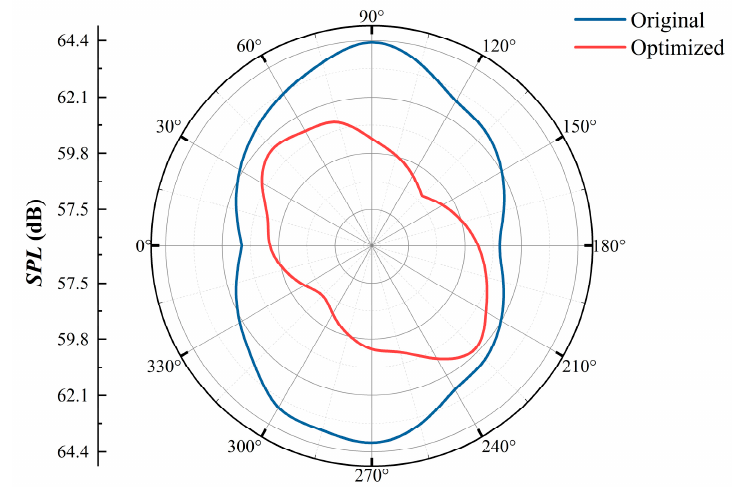
Figure 25. A circumferential noise pointing diagram.